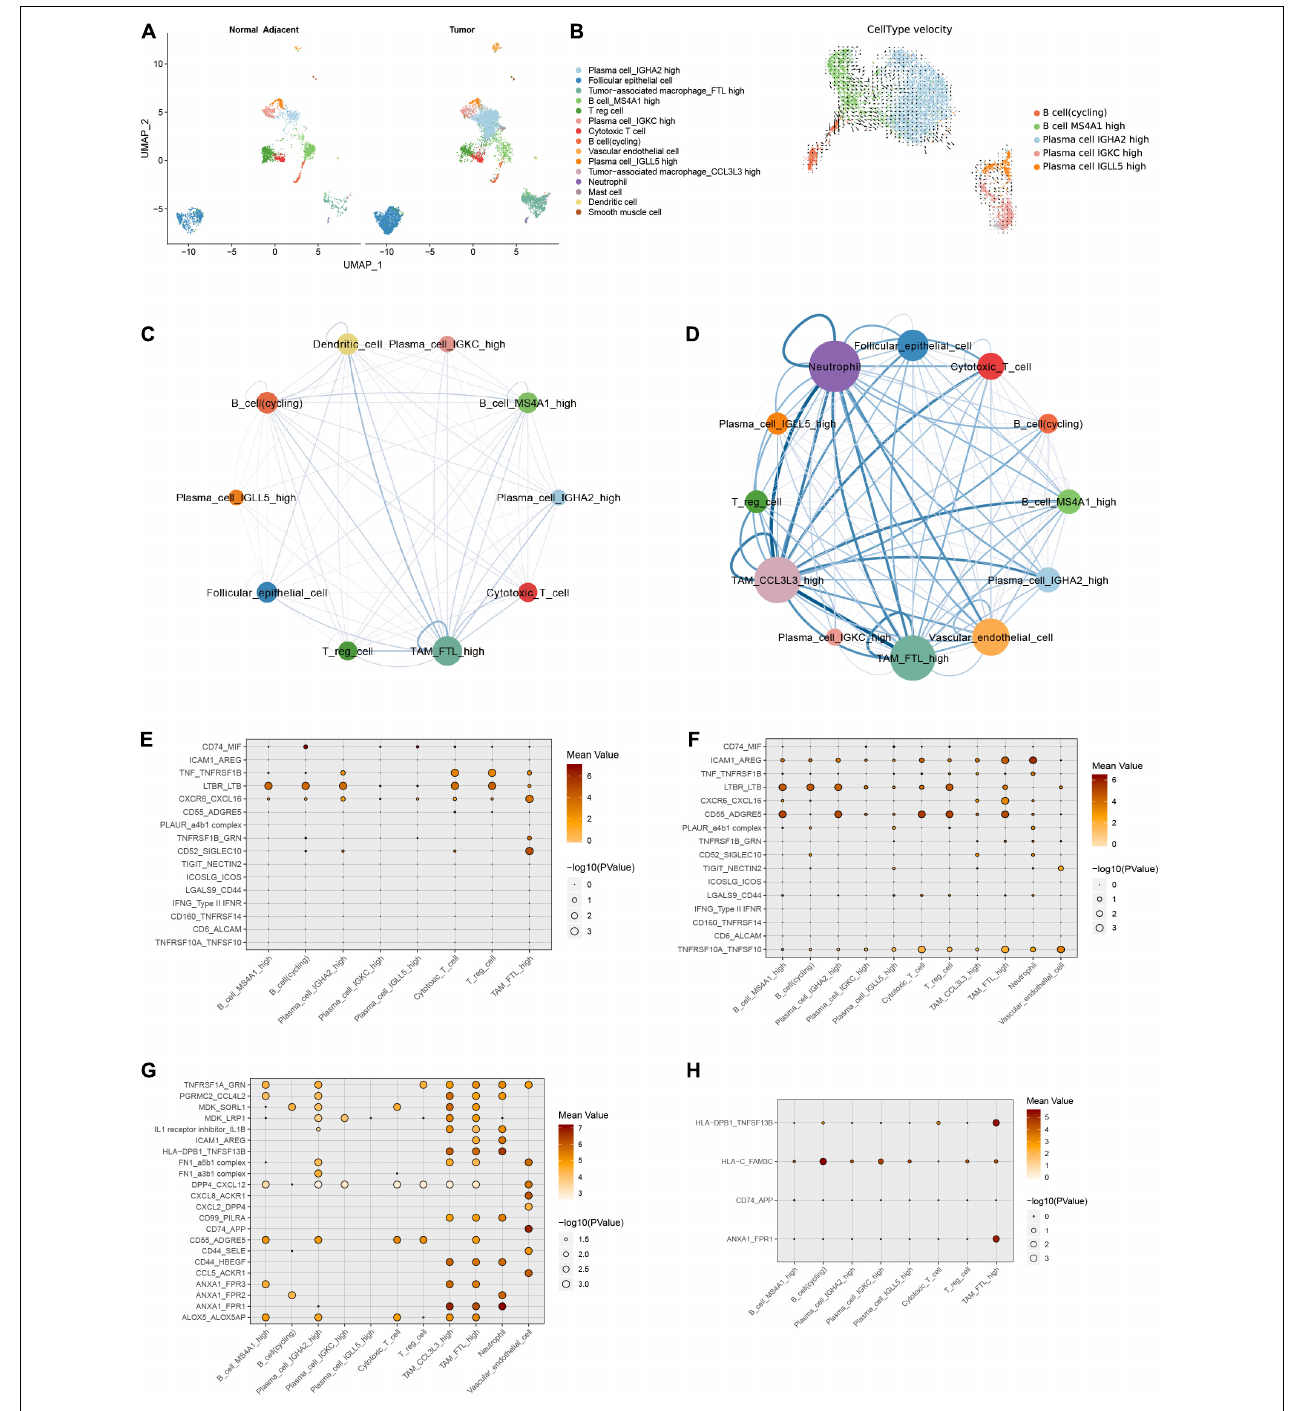
FIGURE 6 | Comparison of adjacent tissues and tumor tissues from PTC patients with concurrent HT. (A) UMAP plot of cell types in adjacent tissues and tumor tissues from PTC patients with concurrent HT. (B) UMAP plot shows RNA velocities of B cell subsets in adjacent tissues and tumor tissues. (C) Cell–cell interaction network of ligand–receptor pairs in adjacent tissues of PTC patients with concurrent HT. The size of the circle represents the total ligand–receptor pairs of each cell type. The line weight represents the ligand–receptor pairs between two linked cell types. (D) Cell–cell interaction network of ligand–receptor pairs in tumor tissues of PTC patients with concurrent HT. (E) Selected ligand–receptor pairs of follicular epithelial cells from adjacent tissue samples in PTC patients with concurrent HT. x axis, receptor cells; y axis, ligand–receptor pairs (expression level is color-coded). (F) Selected ligand–receptor pairs of follicular epithelial cells from tumor samples in PTC patients with concurrent HT. (G) Calculated ligand–receptor pairs of follicular epithelial cells from adjacent tissue samples in PTC patients with concurrent HT. (H) Calculated ligand–receptor pairs of follicular epithelial cells from tumor samples in PTC patients with concurrent HT.